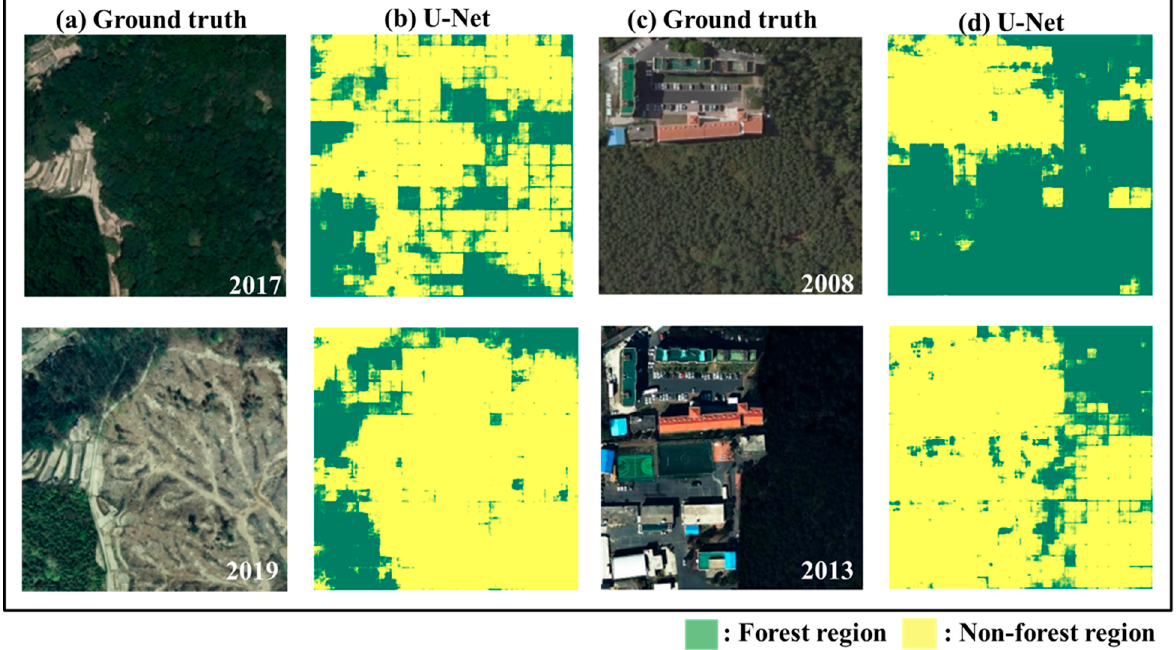
Figure 11. Examples of U-Net test results from the model training with undistinguishable label re- gions in different periods: ( a , b ) are ground truth and U-Net results of Gyeongsang provinces and ( c , d ) are ground truth and U-Net results of Jeju Island, and green color denotes the forest area while yellow indicates non-forest area denoting to 0 and 1, respectively.